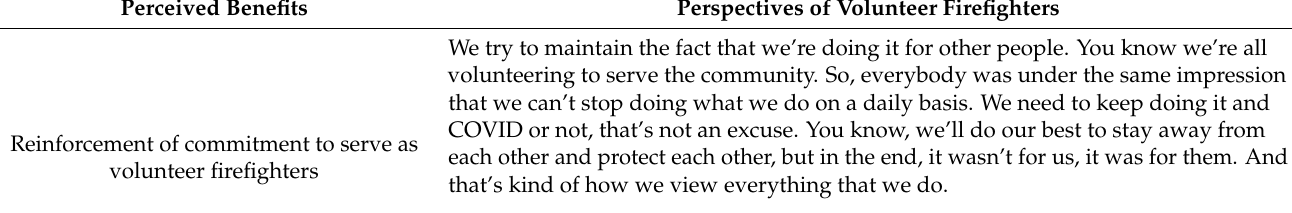
Table 4. Silver Linings of Serving as a Volunteer Firefighter during the COVID-19 Pandemic. Perceived